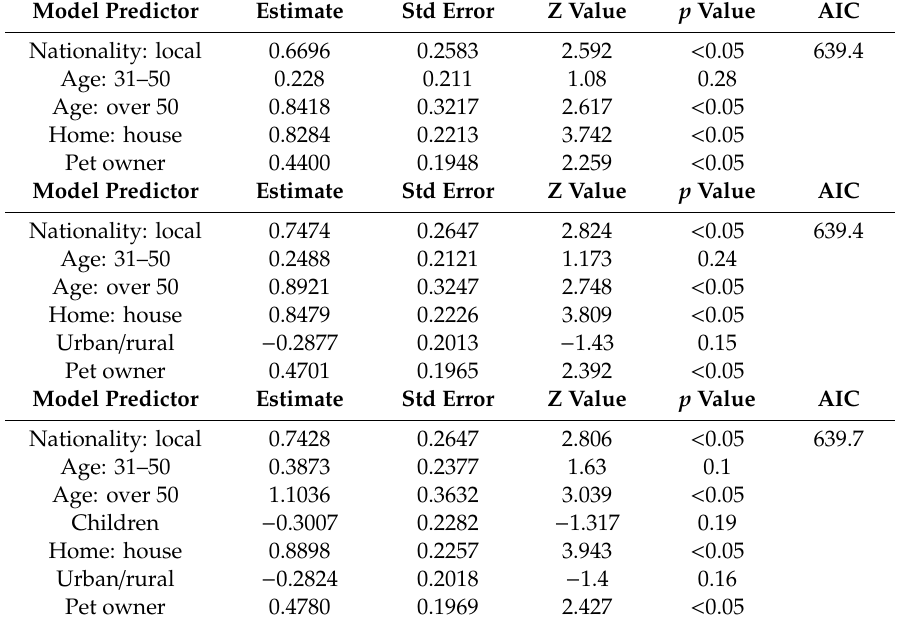
Table 1. Results of generalized linear model (GLM) explaining sociodemographic tortoise owner profile. Only the most parsimonious models (i.e., those with the lowest Akaike information criterion (AIC)) are shown. Significant di ff erences between people ranging from 31 to 50 and over 50 years are observed (Z value: 2.109, p < 0.05). See Table S3 (Supplementary Material) for the full list of models